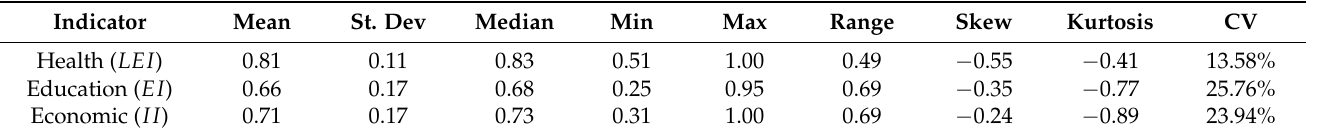
Figure 1. ( a ) Distribution of the Health indicator ( LEI ). ( b ) Distribution of the Education indicator ( EI ). ( c ) Distribution of the Economic indicator ( II ). Table 3. Descriptive statistics for the normalized indicators used to compute the